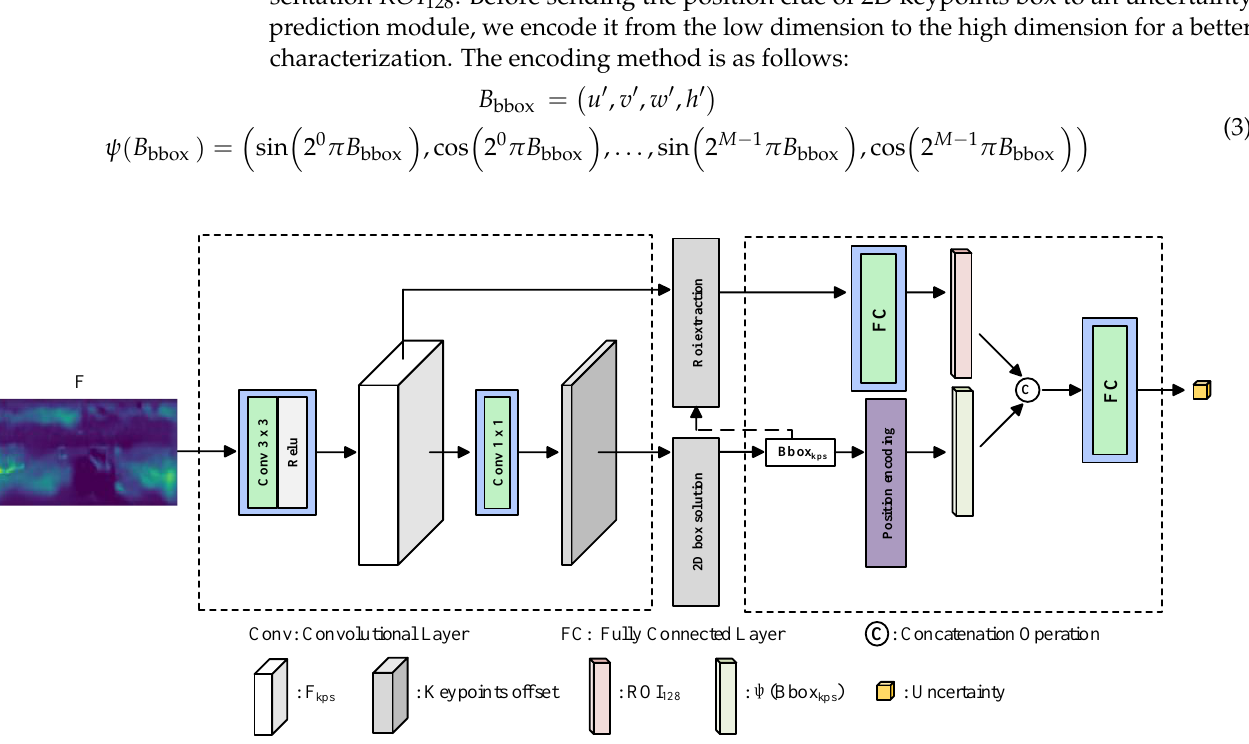
Figure 3. Flow chart of uncertainty prediction.